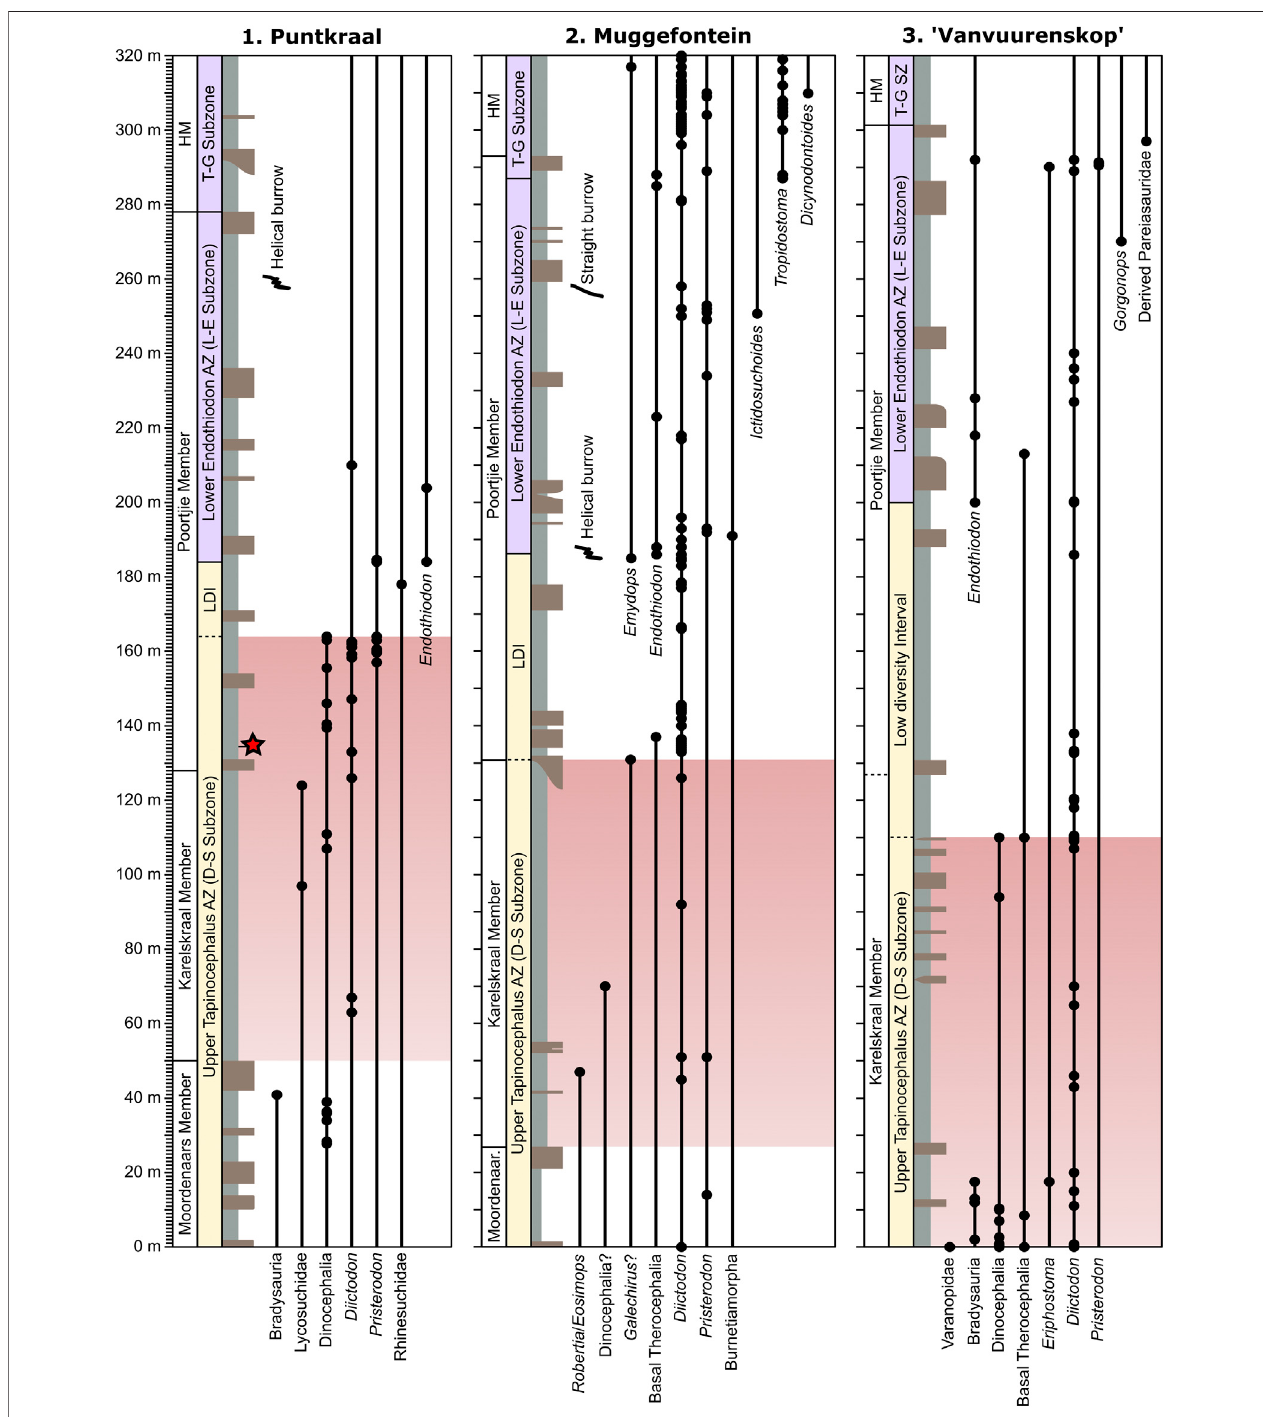
FIGURE 3 | Stratigraphic sections showing fossil occurrences at the three localities: Puntkraal, Muggefontein, and Vanvuurenskop (see Figure 2 for map). Red star (cid:1) dateof260.26 ± 0.081 Ma (Day et al., 2015a).LDI,Low diversity interval; L-E, Lycosuchus - Eunotosaurus ;D-S, Diictodon - Styracocephalus ; H, Hoedemaker Member; T-G, Tropidostoma - Gorgonops